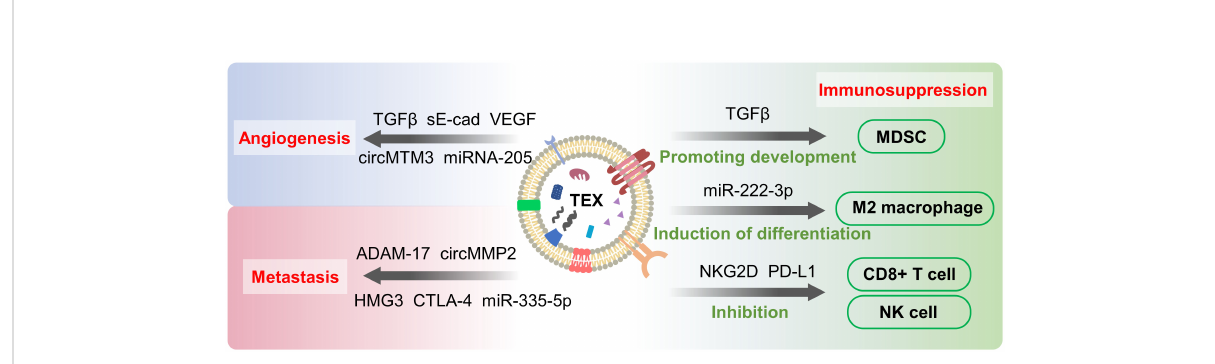
FIGURE 3 Tumor-secreted exosomes (TEXs)-mediated metastasis, angiogenesis and immunosuppression. TEXs promote angiogenesis, metastasis and immunosuppression by delivering “ cargo ” such as proteins and nucleic acids to cancer cells and other cellular in fl uences. These processes contribute to the development of cancer and cause changes in TME as